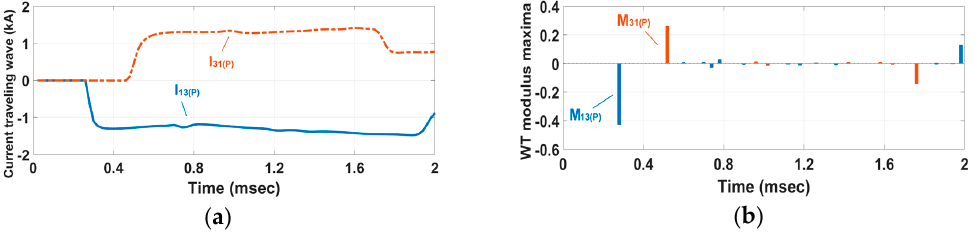
Figure 12. ( a ) Waveforms of current traveling waves at both ends of the positive line in the segment L 13 ; ( b ) Waveforms of their corresponding WT modulus maxima.